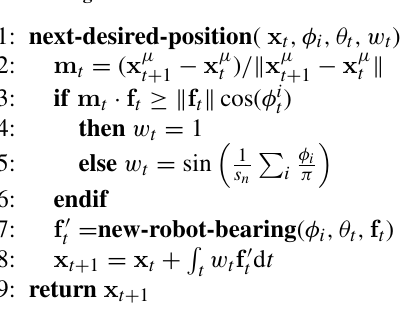
Table 5 Algorithm Next robot’s desired position